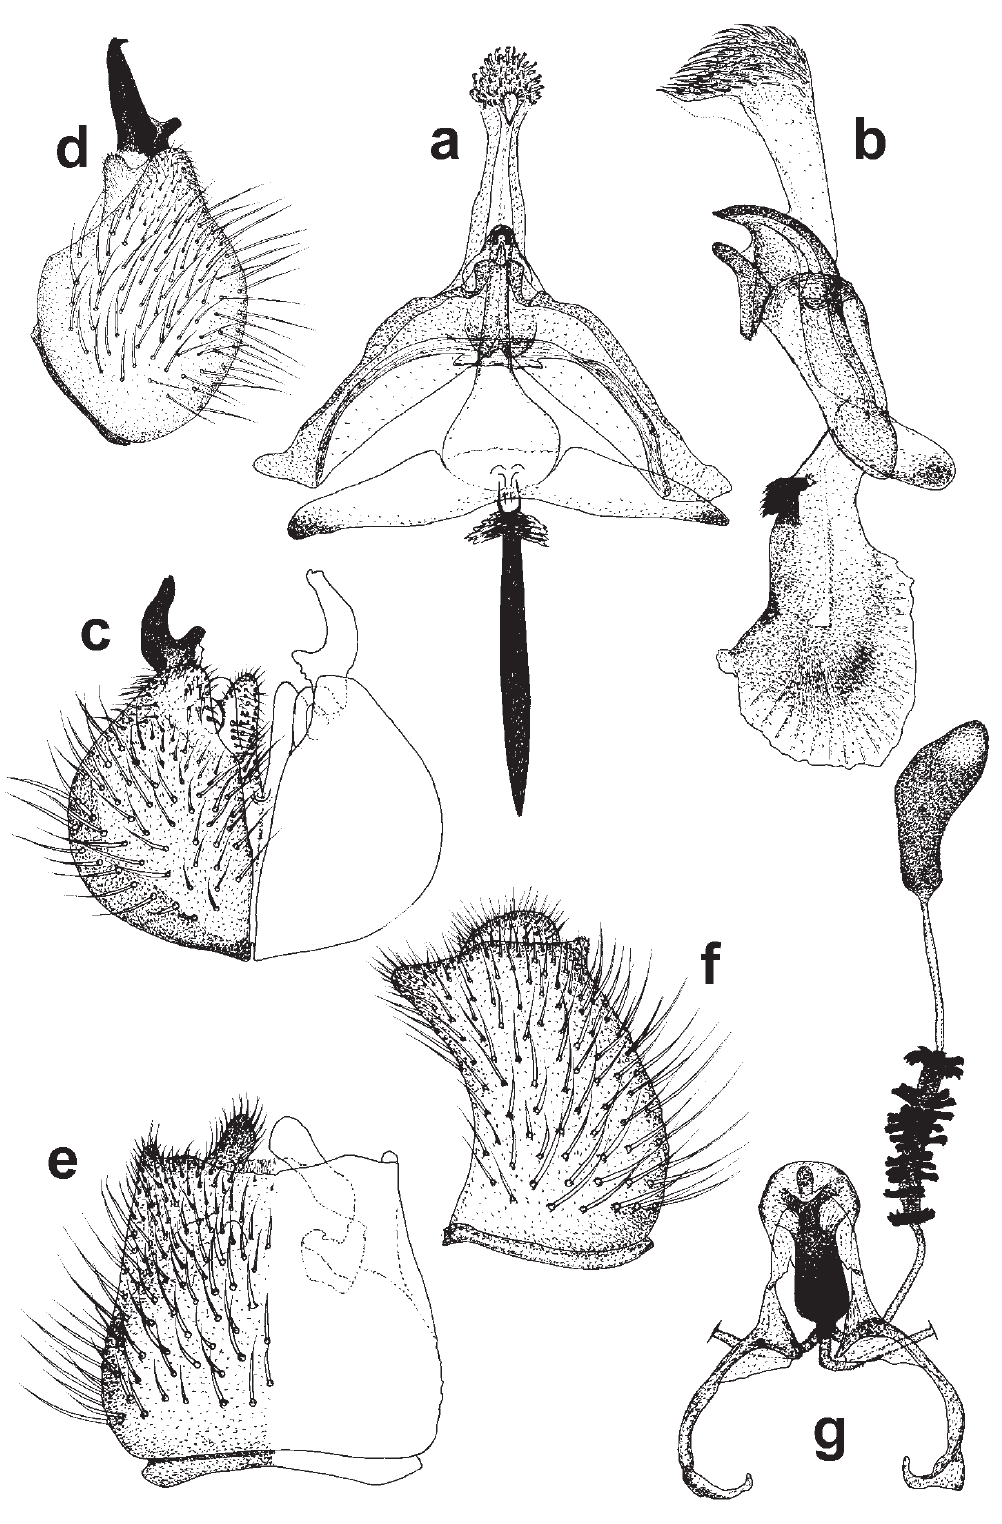
Fig. 54. Protypusia punctipennis (Loew, 1846) gen. et comb. nov. a . Epiphallic complex ventral. b . Epiphallic complex lateral. c . Gonocoxite ventral. d . Gonocoxite lateral. e . Epandrium dorsal. f . Epandrium lateral. g . Female genitalia